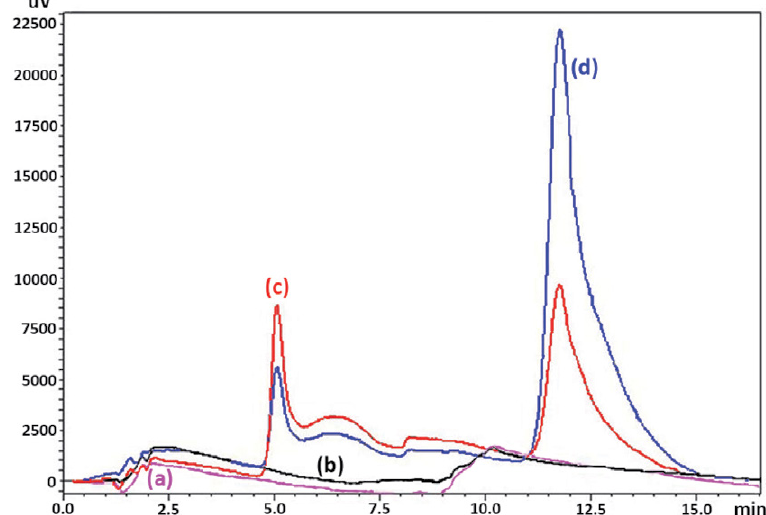
Figure 9. HPLC chromatograms, (a,b) before spiking with analytes in plasma at the wavelength of 308 and 284 nm for lamotrigine and carbamaze- pine, respectively,, (c) 14 mg L –1 (lamotrigine) and (d) 4 mg L –1 (carbamazepine) spiking of analytes in plasma after extraction via proposed method at optimum conditions . (The retention time of LTG was 5.1 min and the retention time of CBZ was 12.1 min at the measurement in the maximum wavelengths).